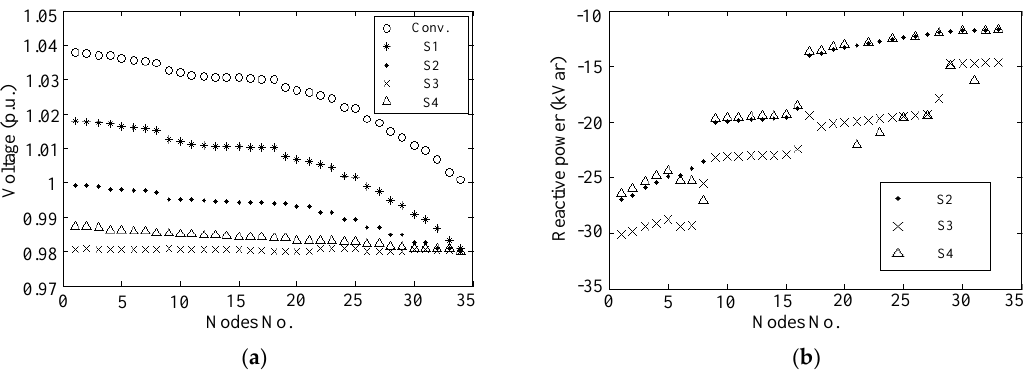
Figure 7. ( a ) Voltage and ( b ) reactive power distributions of the wind farm under different control methods.